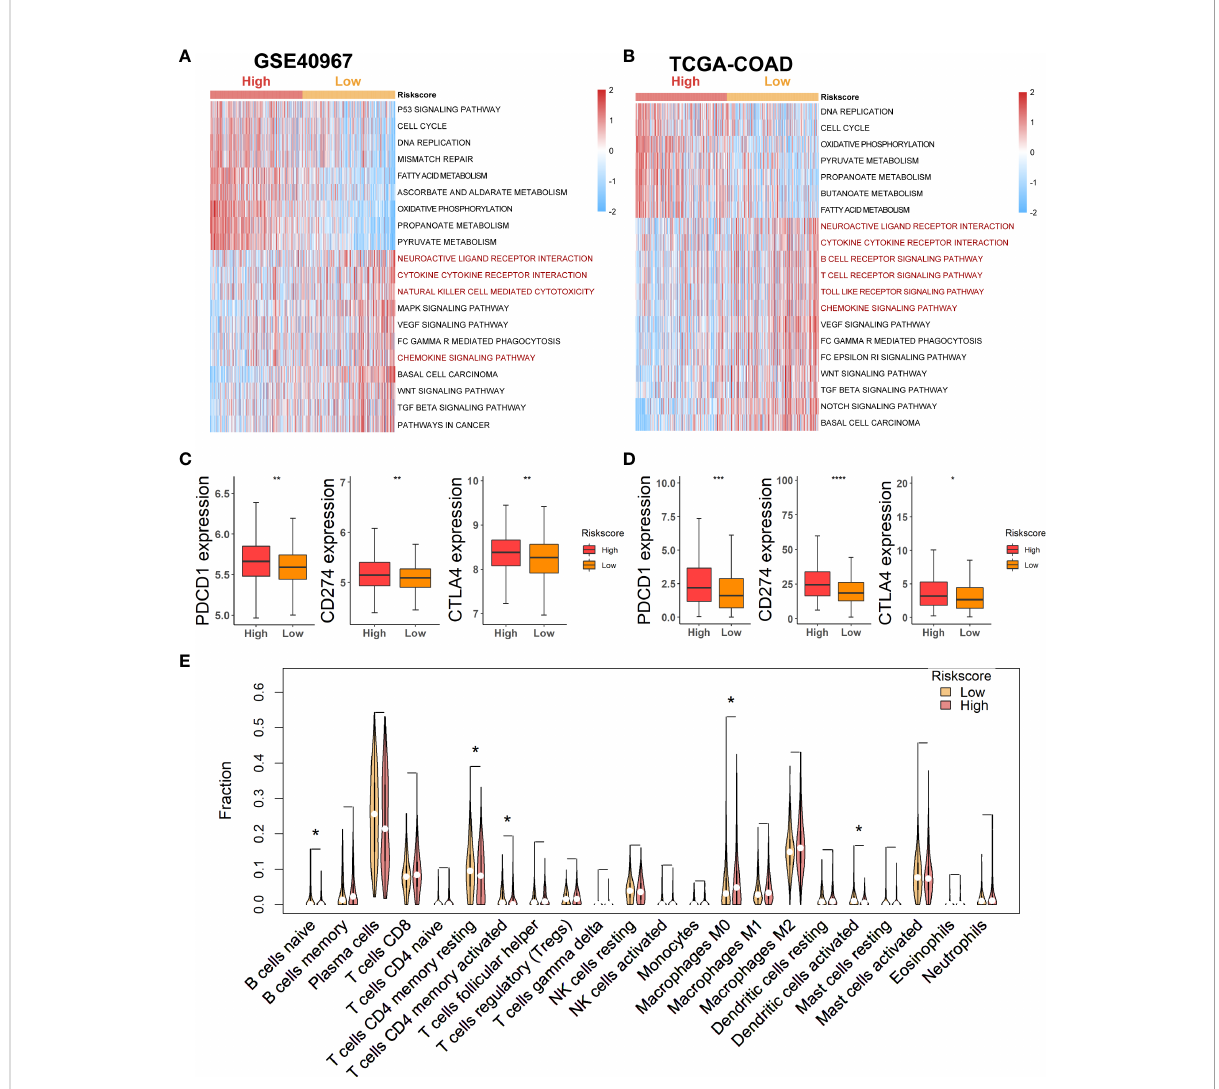
FIGURE 6 Estimation of potential relationship between various risk groups and immune landscape. (A) Results of GSVA analysis in GSE40967 to depict enriched immune-related pathways. (B) Results of GSVA analysis in TCGA-COAD to reveal enriched immune-related pathways. (C, D) Comparing expression levels of three classical markers of immune checkpoint between high- and low-risk groups in GSE40967 (C) and TCGA- COAD (D) separately. (E) Violin plots to show the relatively in fi ltrating abundances of 22 immune cells in COAD patients of GSE40967. *p <